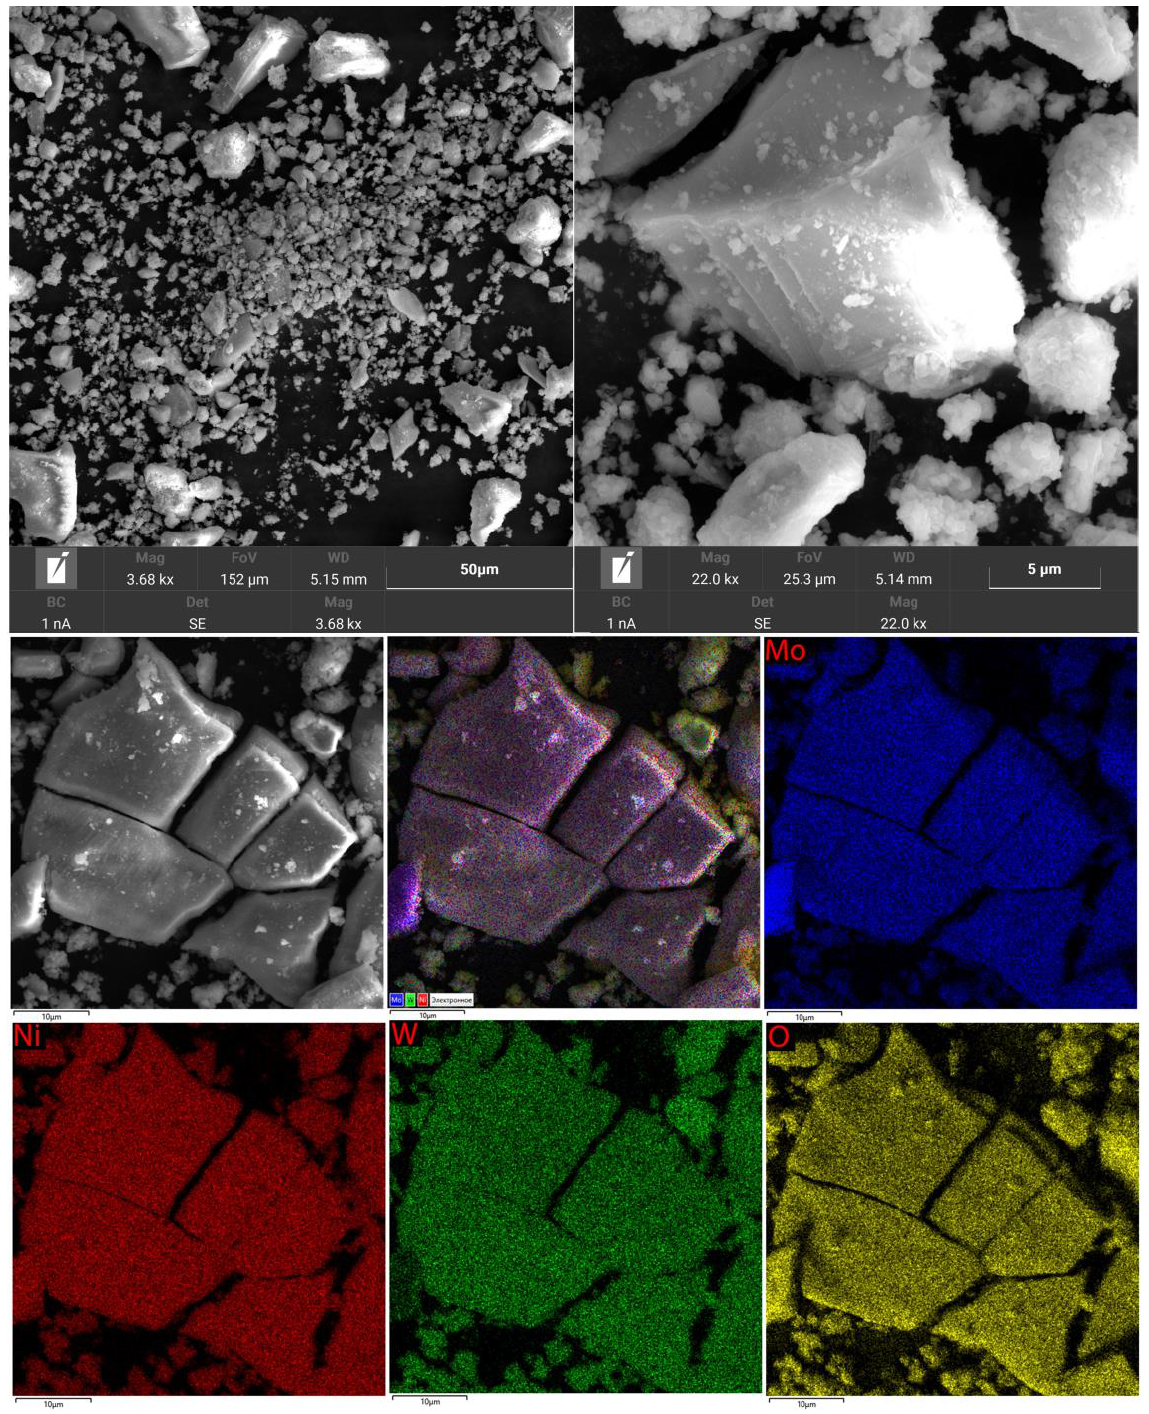
Figure 1. SEM and EDX images of Ni 1 Mo 0.5 W 0.5 –HT–1 catalyst at different resolutions.